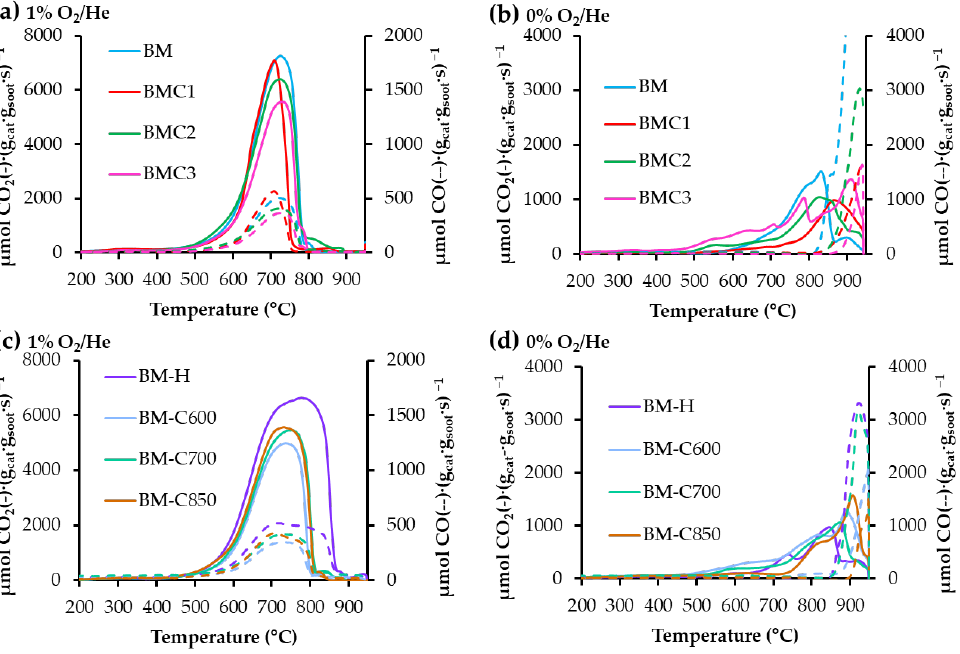
Figure 6. Evolved CO 2 (solid line) and CO (dotted line) profiles during soot oxidation: ( a , c ) in (1% O 2 /He) and ( b , d ) in He.